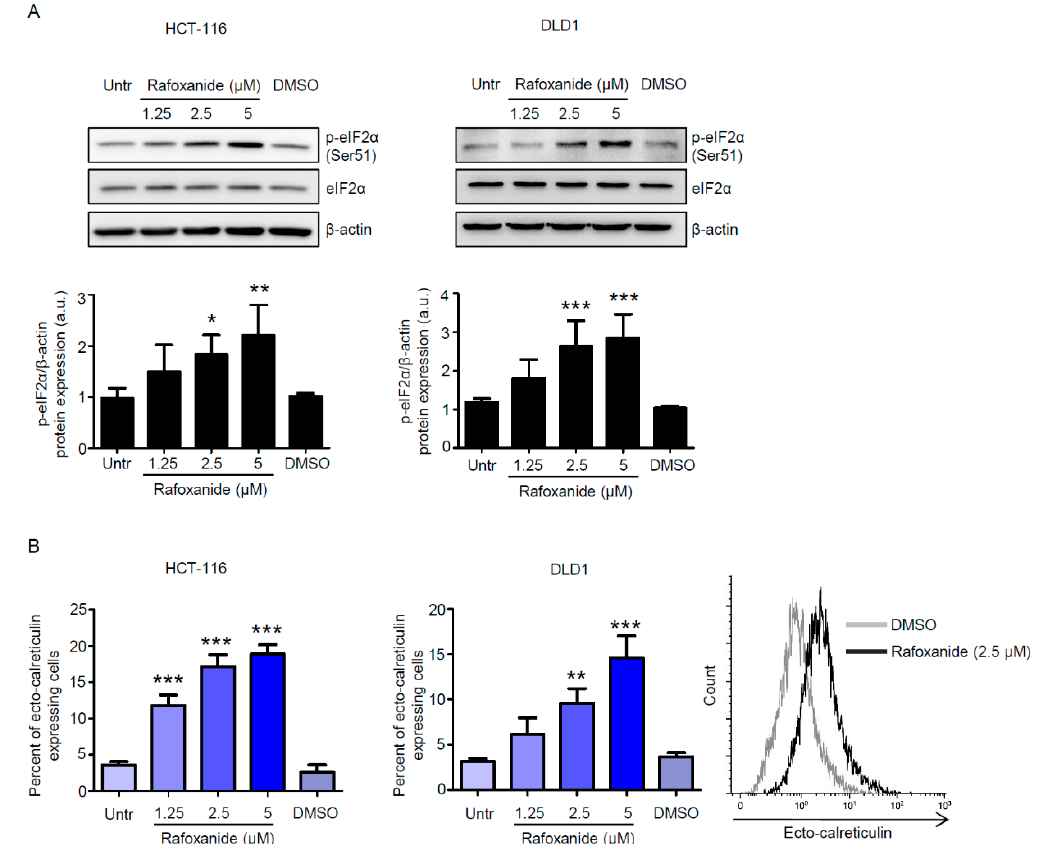
Figure 1. Rafoxanide induces eIF2 α phosphorylation and calreticulin exposure on the cell surface in CRC cells. ( A ) Representative Western blotting for p-eIF2 α (Ser51) and eIF2 α in extracts of HCT-116 and DLD1 cells either left untreated (Untr) or treated with either dimethyl sulfoxide (DMSO) (vehicle) or rafoxanide for 30 min. β -actin was used as loading control. The full blots are available in Figure S1 from Supplementary Materials. Data are representative of four experiments where similar results were obtained. Lower insets: Quantitative analysis of p-eIF2 α (Ser51) / β -actin protein ratio in total extracts of HCT-116 and DLD1 as measured by densitometry scanning of Western blots. Values are expressed in arbitrary units (a.u.) and are the mean ± SD of four experiments. Data were analyzed using one-way analysis of variance (ANOVA) followed by Dunnett’s post hoc test. DMSO vs. rafoxanide-treated cells, * p < 0.05, ** p < 0.01, *** p < 0.001. ( B ) Histograms showing the percentage of ecto-calreticulin-expressing HCT-116 and DLD1 cells either left untreated (Untr) or treated with either DMSO or rafoxanide for 6 h. Results indicate the percentage of ecto-calreticulin-expressing cells as assessed by flow-cytometry analysis. Data are expressed as mean ± SD of three experiments. Data were analyzed using one-way analysis of variance (ANOVA) followed by Dunnett’s post hoc test. DMSO vs. rafoxanide-treated cells, ** p < 0.01, *** p < 0.001. Right inset. Representative histograms showing ecto-calreticulin in HCT-116 treated with either DMSO or rafoxanide as assessed by